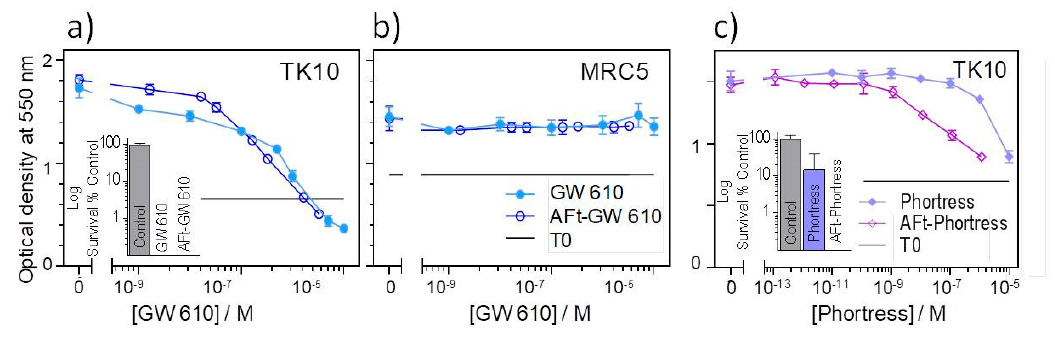
Figure 8. Representative growth inhibitory dose-response profiles following exposure of ( a ) and ( c ) TK10 carcinoma cells and ( b ) MRC-5 fibroblasts (72 h) to naked- or AFt-encapsulated ( a ) and ( b ) GW610 or ( c ) Phortress (points are means ± SD, n = 4). Inset in ( a ) and inset in ( c ): TK10 clonal survival following 24 h exposure of cells to naked and AFt-encapsulated GW610 with GI 50 values. Data points are the mean ± SD of 3 independent trials ( n = 3 per trial).